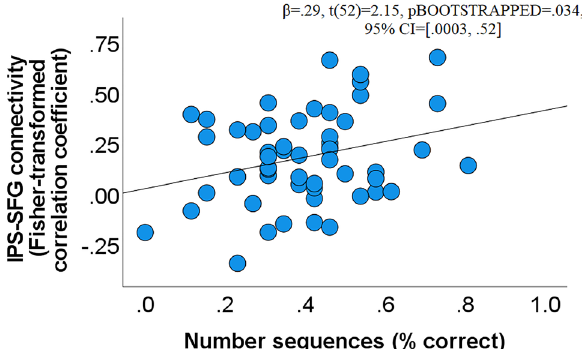
Figure 2. Scatterplot depicting a positive association between the accuracy in the number sequences test and the connectivity between the left IPS and the left